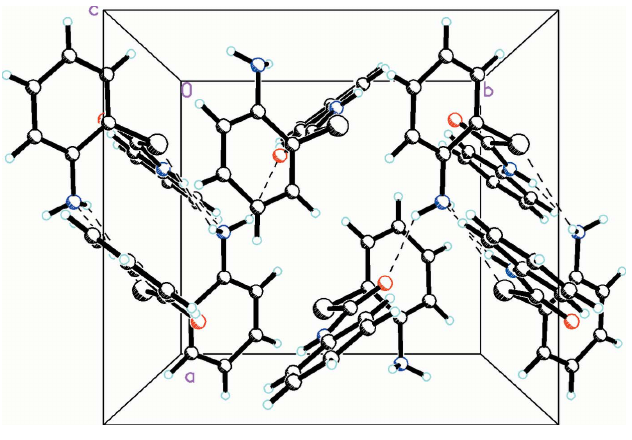
Figure 2 A packing diagram viewed along [001]. Hydrogen-bonding interactions are shown with dashed